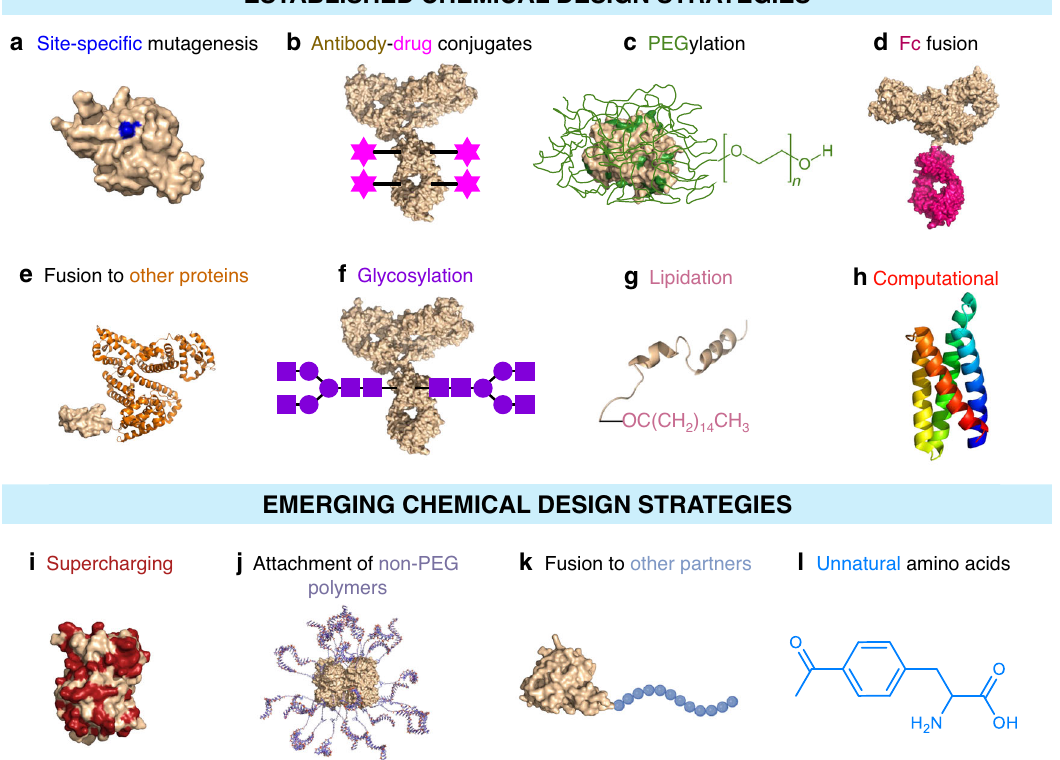
Fig. 3 | Established and emerging chemical design strategies employed to generate protein-based therapeutics. a Site-speci fi c mutagenesis. b Antibody- drug conjugates. c PEGylation. d Fc fusion. e Fusion to other proteins. f Glycosylation. g Lipidation. h Computational. i Supercharging. j Attachment of